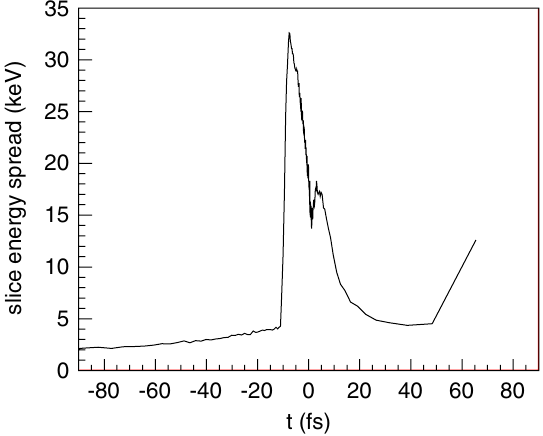
FIG. 12. Rms slice energy spread. The slice energy spread at the central slices is about 17